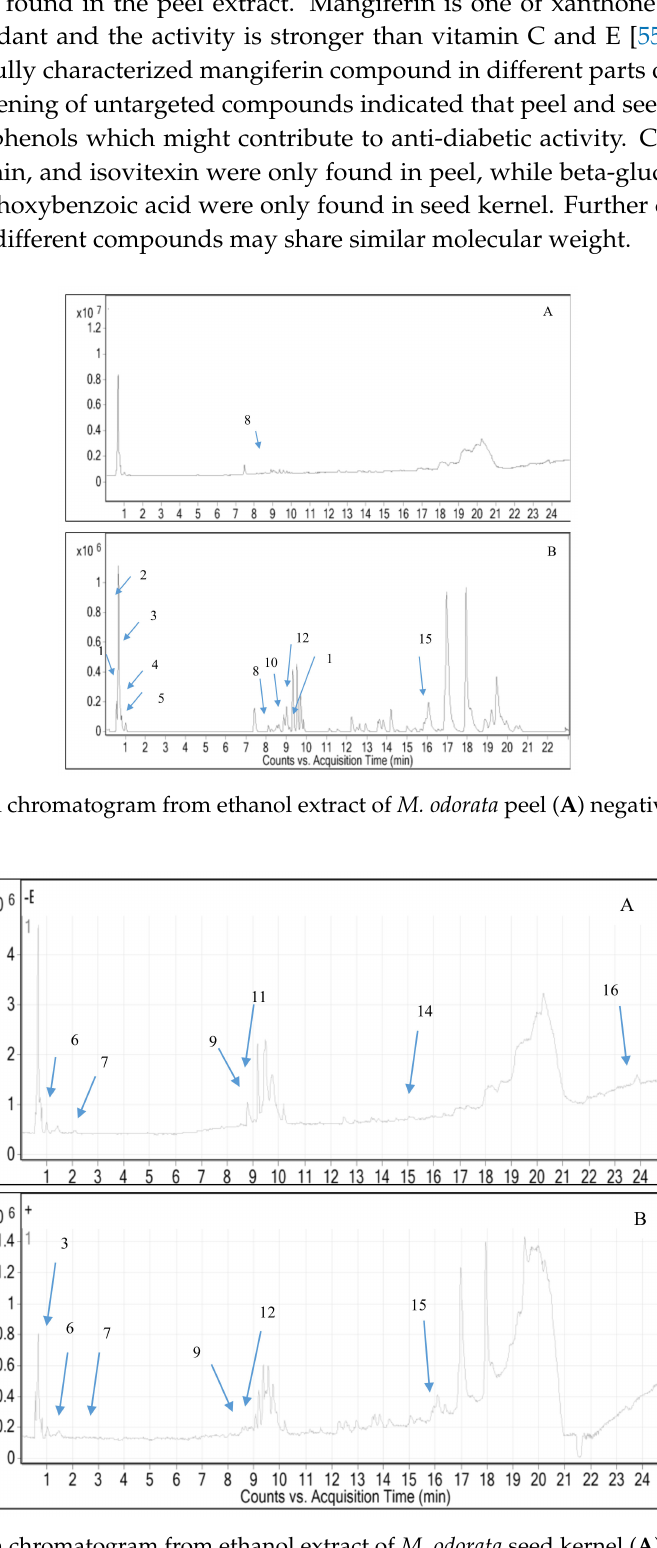
Figure 2. Total ion chromatogram from ethanol extract of M. odorata seed kernel ( A ) negative mode and ( B ) positive